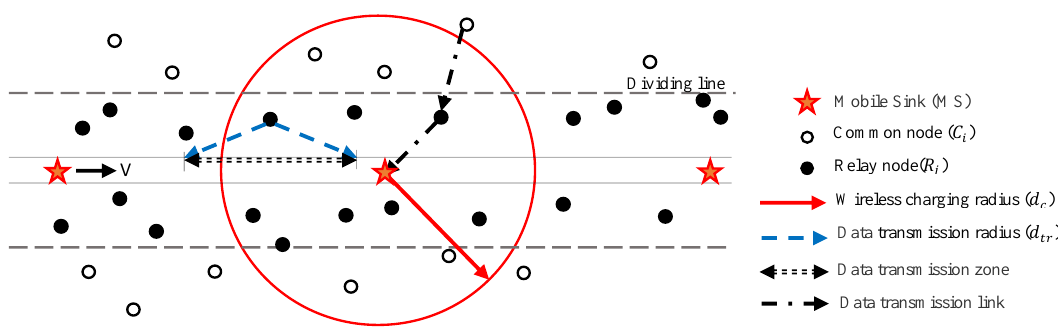
Figure 1. Description of a system model of wireless rechargeable sensor networks (WRSNs)